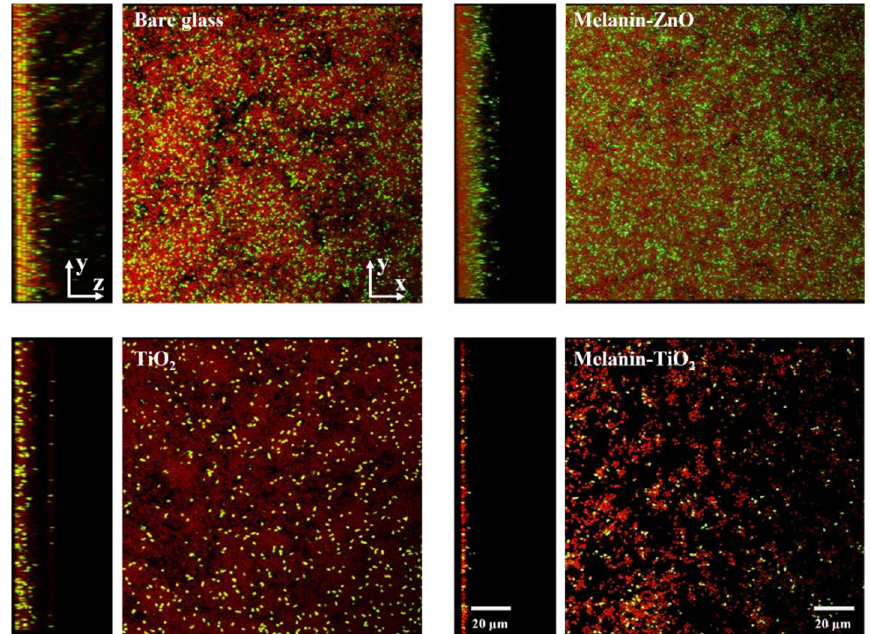
Figure 5. Confocal laser scanning microscopy Z-scan projections performed with live/dead staining of 48h biofilm growth on bare glass (control) and functionalized samples (nanoparticles of melanin- ZnO, TiO 2 , melanin TiO 2 ). For each sample, top view ( right ) and side view ( left ) display overlaid images. Live bacteria are reported in green, dead in